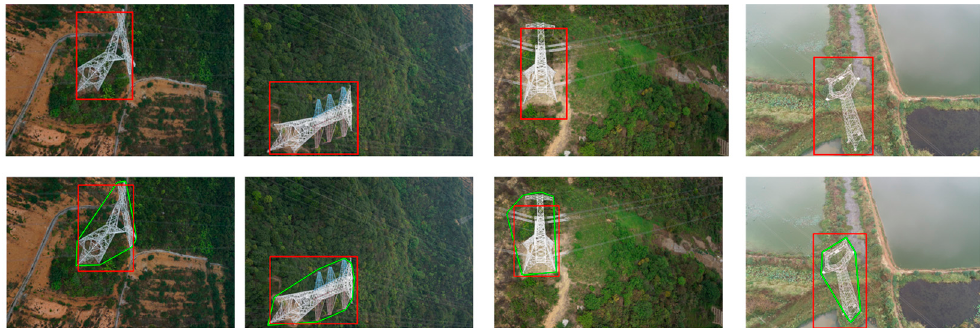
Figure 11. The results of pylon detection. The first row is the result of pylon detection by the DPM method and the second is the proposed method. The red rectangle is the detected bounding box location of the pylon. In the second row, the green polygon is the proposed region.